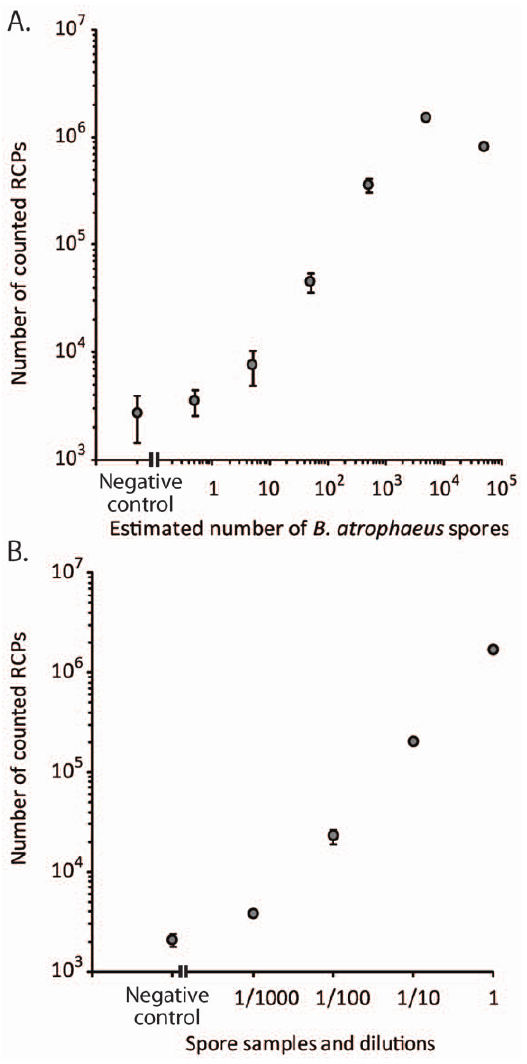
Figure 4. Detection of BG spores using PLA. A) Quantitative response measured in a dilution series of BG spores. Error bars, 6 1 s.d.; n=3. B) Detection and identification of BG spores in environmental samples of air. A positive sample was diluted in a background sample collected for 15 min. Error bars, 6 1 s.d.; n=2.